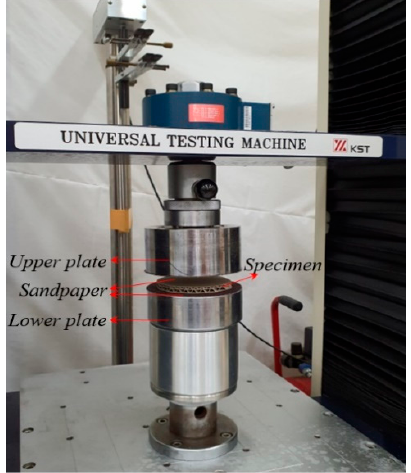
Figure 1. Flat crush test fixture of the corrugated paperboard.